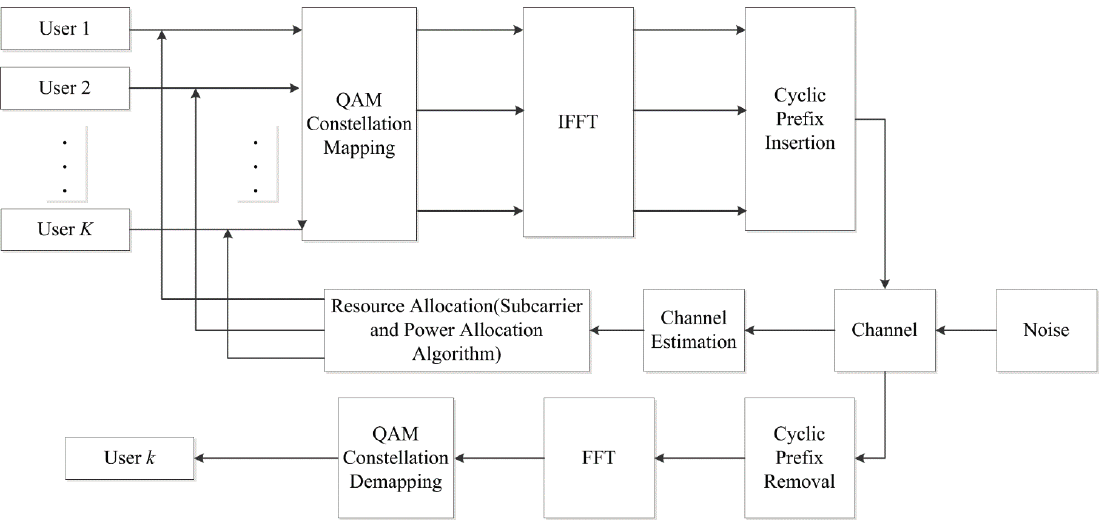
Figure 1. The downlink of orthogonal frequency division multiple access (OFDMA) system for wireless sensor